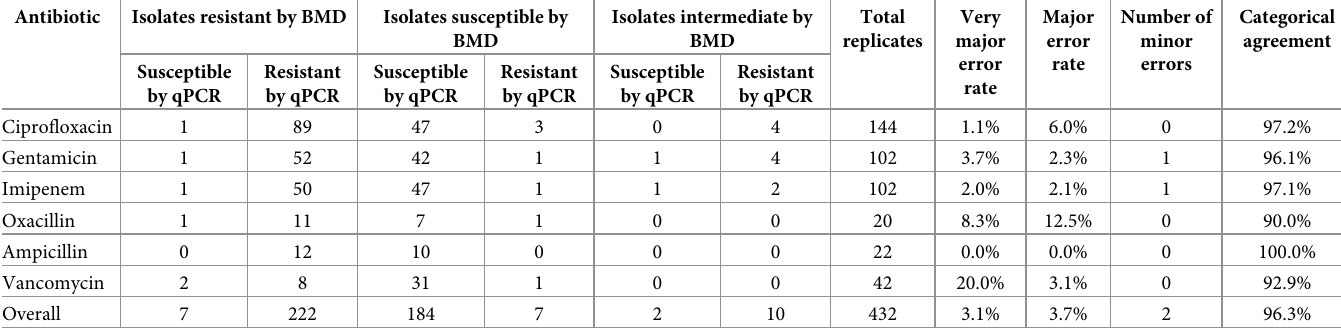
Table 2. Categorical agreement and errors for the tested isolates.